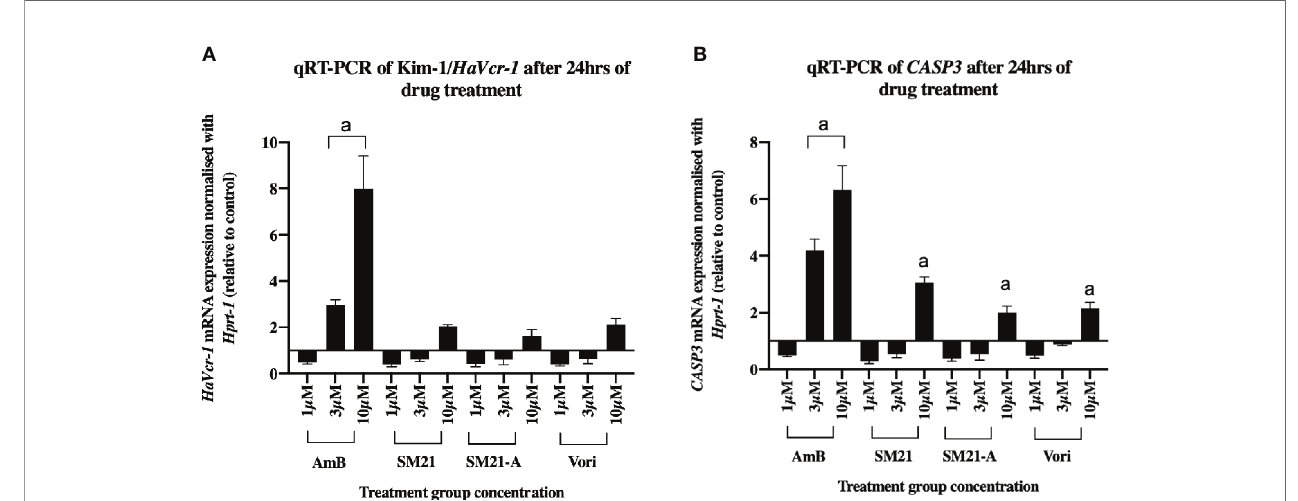
FIGURE 3 | mRNA levels of HaVcr-1 /Kim-1 and CASP3 /Caspase-3 biomarkers in HK-2 cells after each compound treatment for 24 h. (A) HaVcr-1 mRNA and (B) CASP3 mRNA. Data are presented as mean standard deviation. Signi fi cantly difference ***P < 0.001 is depicted as "a" in the graphs, n>3 relative to control value as 1 (three independent assays with two technical replicates in each assay). Relatively higher gene expression of Havcr1, CASP3 at lower concentration (3 m M) in AmB was observed compared to SM21 treatment groups (SM21 and its analogue) and voriconazole. HK-2, immortalized proximal tubule epithelial cell; AmB, Amphotericin B; SM21-A, SM21 Analogue; Vori, Voriconazole.